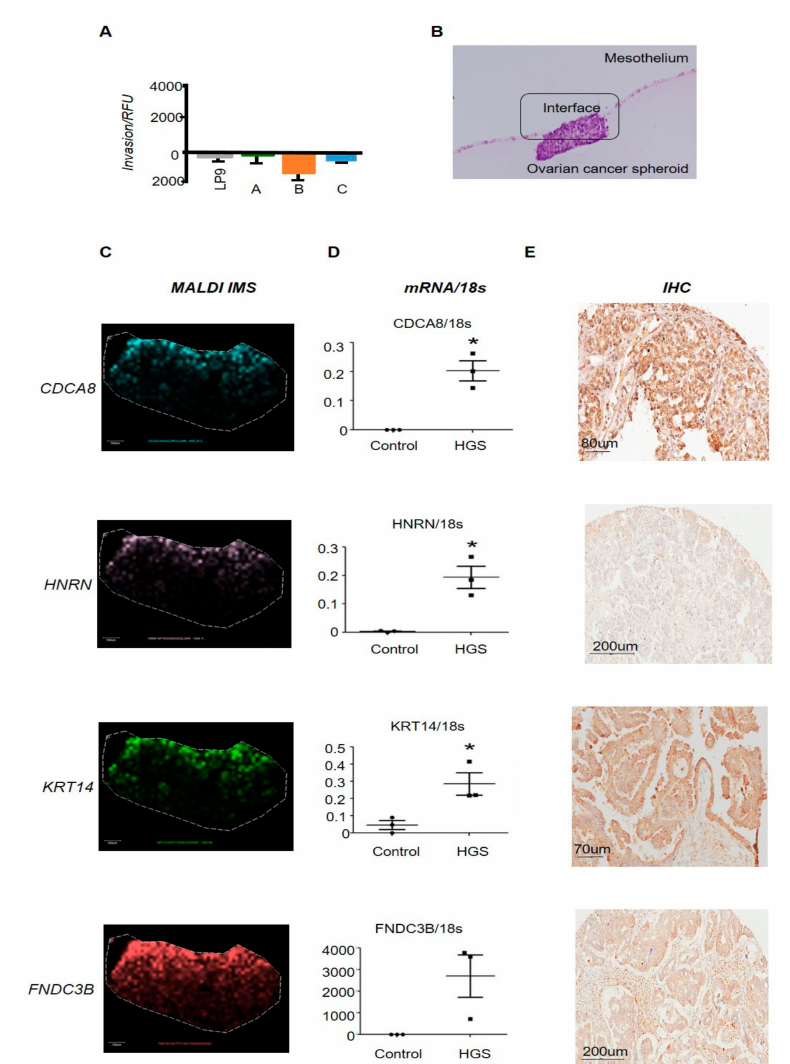
Figure 2. ( A ) Parallel endpoint Boyden chamber assays. Boyden chamber assays using labelled mesothelial cells overlaid with individual patient-derived ovarian cancer spheroids; we observe no invasion of the mesothelial cells at MALDI imaging collection points; n = 3 wells / sample of one representative experiment. ( B ) Haemotoxylin and Eosin (H&E) staining of the invasive interface. H&E staining identifying the invading interface of ovarian cancer spheroid mesothelial co-cultures and the interface used for MALDI imaging mass spectrometry (IMS). ( C ) MALDI IMS of the invading interface. MALDI IMS identifies: CDCA8, HNRN, keratin-14 (KRT14) and FNDC3B expressed at the invading interface of ovarian / mesothelial co-cultures. ( D ) Representative qRT-PCR of MALDI identified candidates using fresh-frozen confirmed primary high-grade serous ovarian tumours or normal whole ovary ( n = 3 / group) where individual data points represent individual patient samples. ( E ) Representative IHC of individual MALDI identified candidates in HGSC primary ovarian